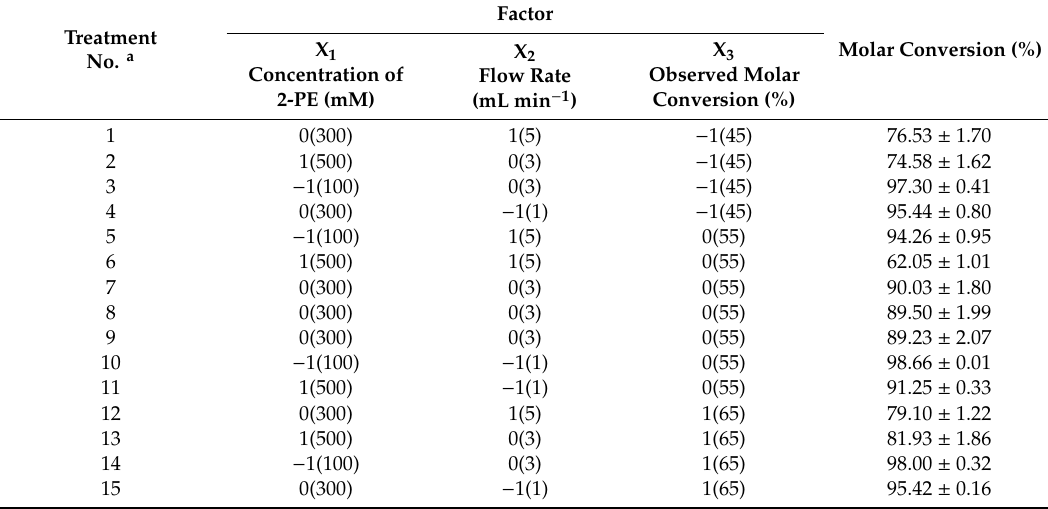
Three-level-three-factor Box–Behnken design and the experiment data for response surface